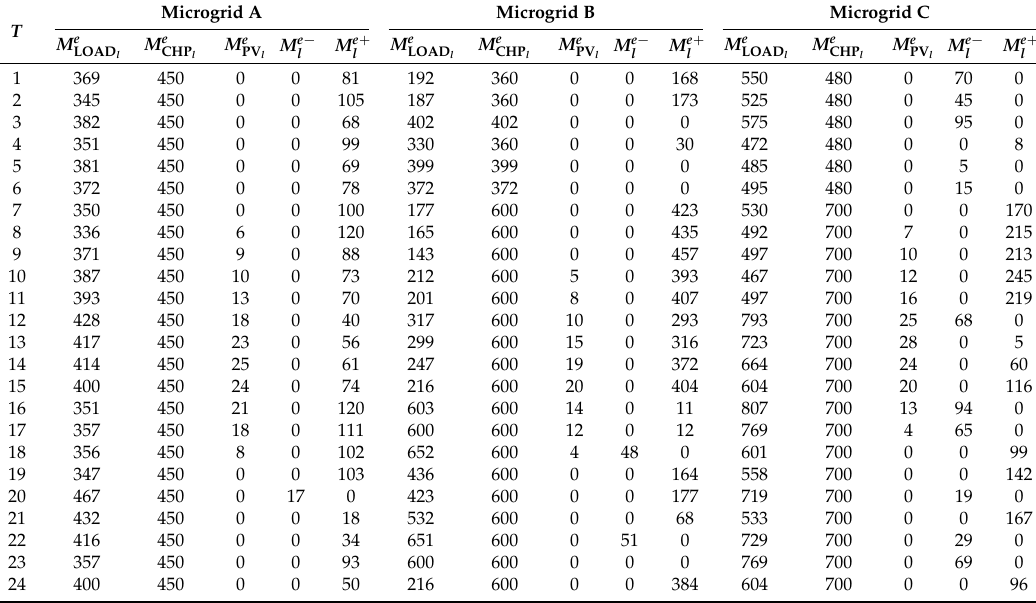
Table 3. Local optimization of electric energy in Step